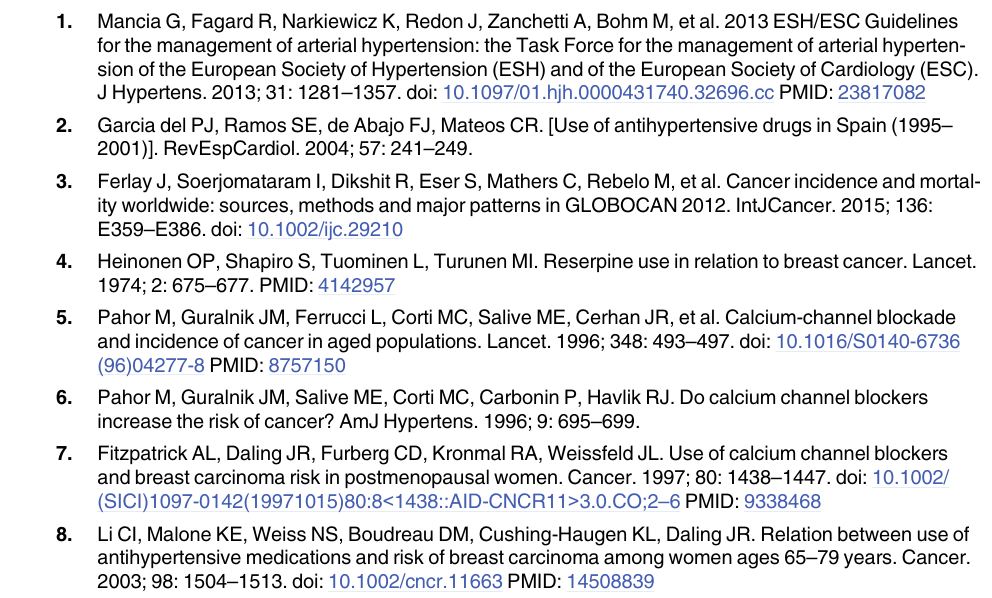
S1 Table. Association between duration of antihypertensive drug consumption ( < 5 years and (cid:1) 5 years) and the risk of breast cancer according to women ’ s characteristic. Category reference no antihypertensive treatment. S2 Table. Association between duration of antihypertensive drug consumption ( < 5 years and (cid:1) 5 years) and the risk of breast cancer according to characteristics of tumor and immunohistochemistry. Category reference no antihypertensive